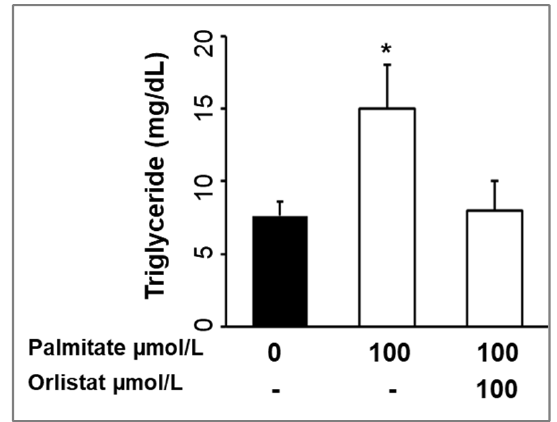
Figure 7. Effects of Orlistat on the Lipid Content. MECs were treated with palmitic acid and orlistat added to the lactation medium in the basolateral chamber for 48 h. MEC “milk” was analyzed for triglyceride levels. Each treatment was performed in quadruplicate, and differences between treated and untreated MECs were compared using ANOVA with Dunnett’s post-hoc test. Values are Mean ± SE; * p < 0.01 treated vs. untreated MECs.